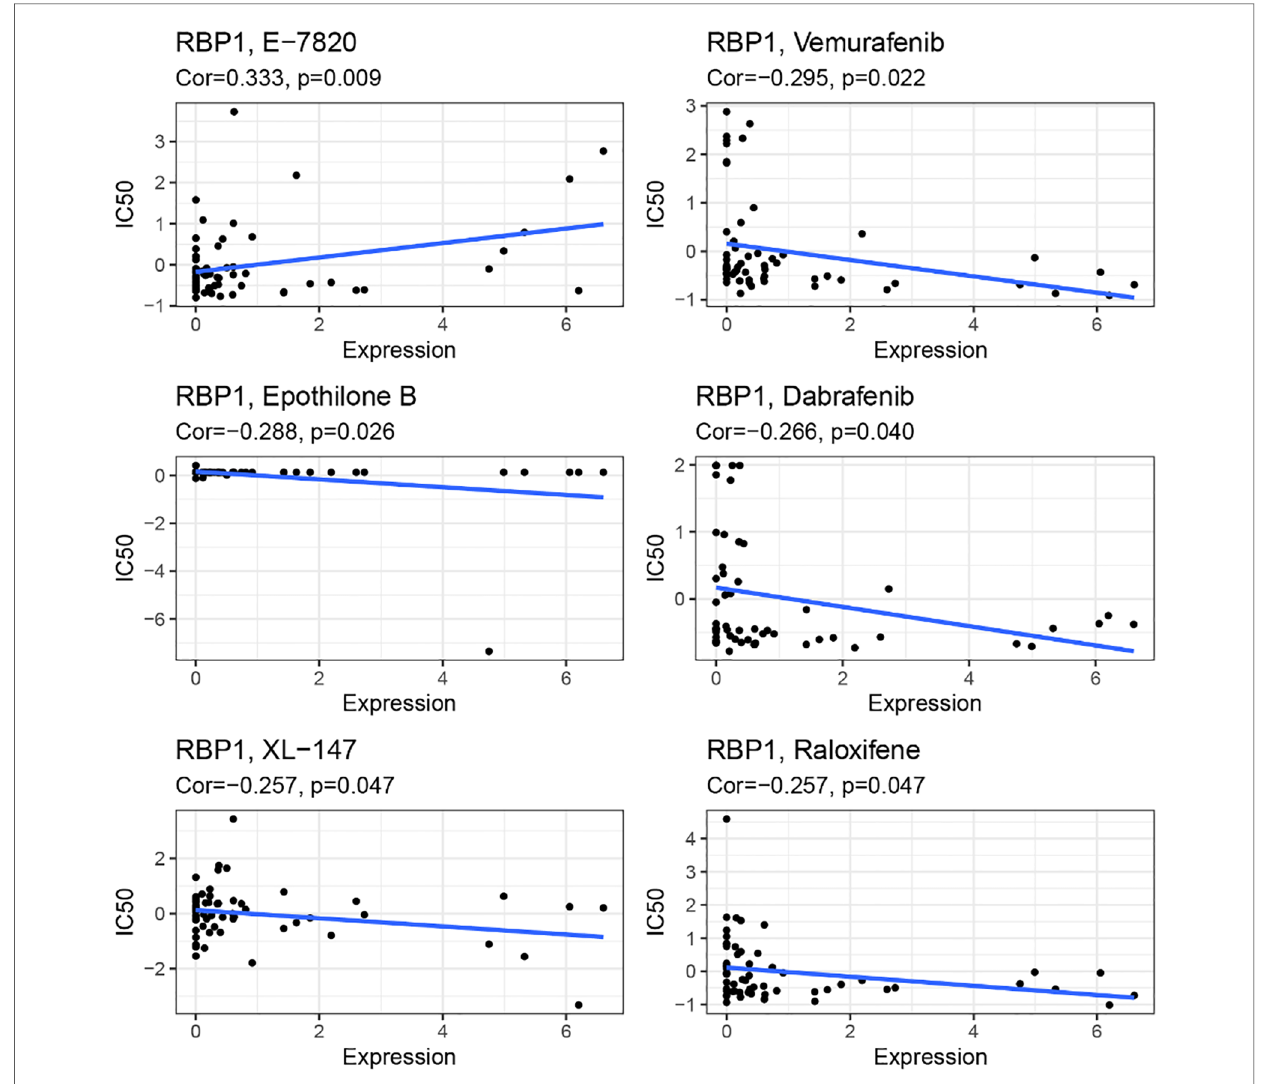
FIGURE 14 Drug sensitivity